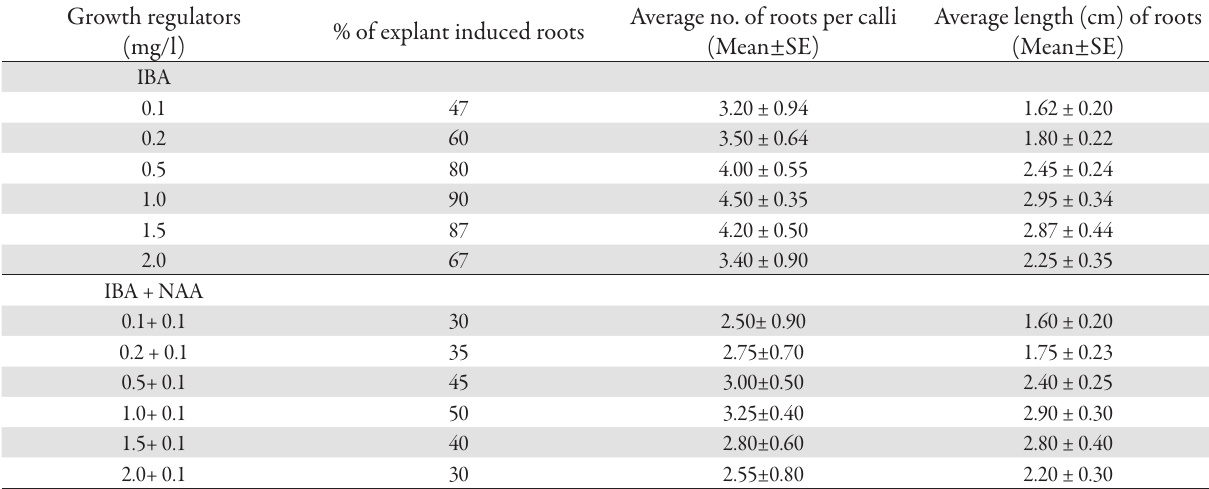
Tab. 5. Effect of NAA and IBA on root induction from regenerated embryo derived shoots. There were 3 replications for each sample Growth